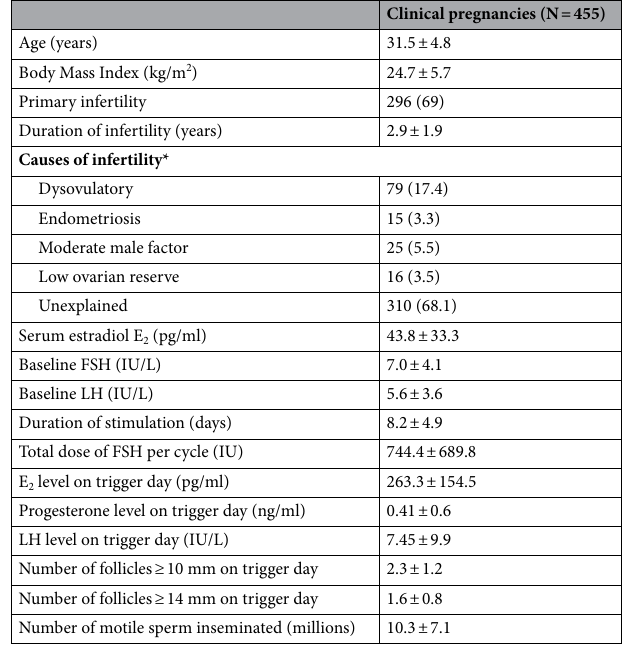
Table 1. Baseline characteristics of patients/cycles who achieved a clinical pregnancy. Data are expressed as n (%) percentage or mean + / − standard deviation. *Some couples could have had multiple causes of infertility.